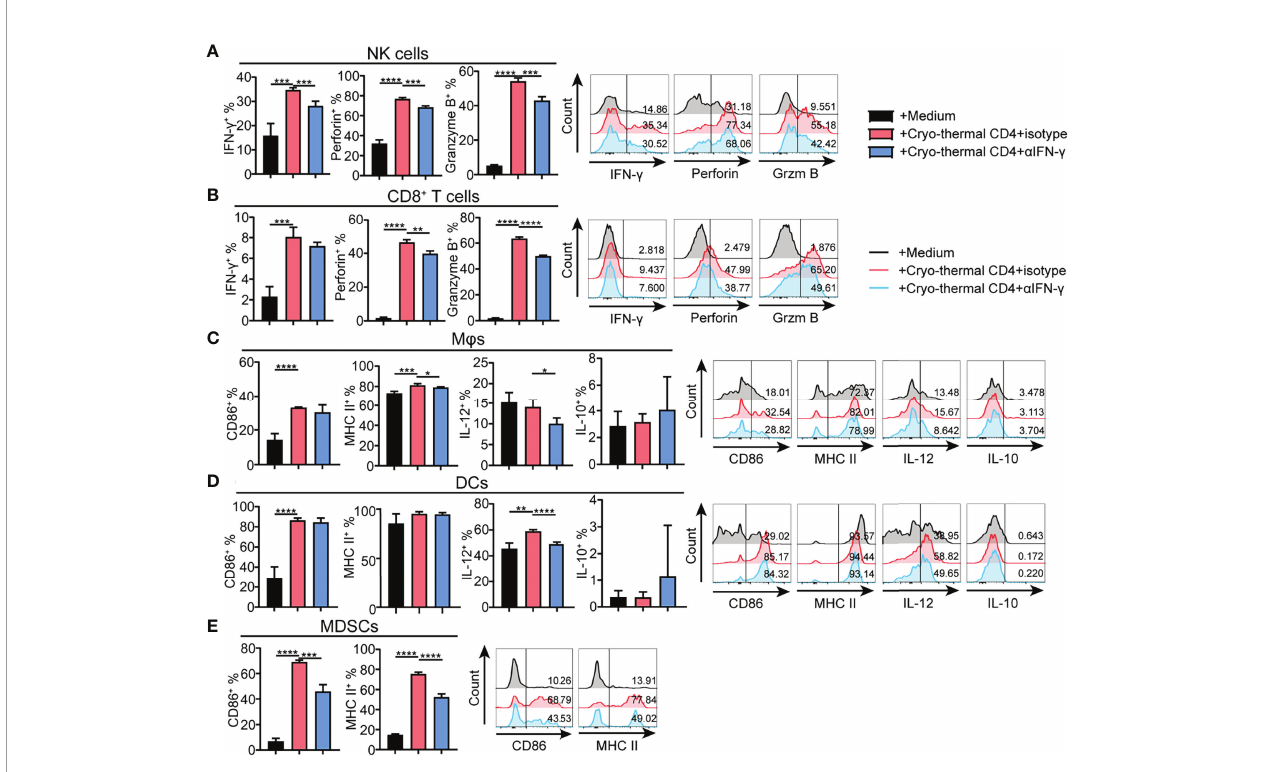
FIGURE 6 | Phenotype of immune cells regulated by cryo-thermal CD4 + T cells derived IFN- g in vitro . (A-E) MACS-isolated cryo-thermal CD4 + T cells were stimulated with anti-CD3 monoantibody, washed and then cocultured with cryo-thermal CD4 - splenocytes in the presence of 10 m g/mL isotype or anti-IFN- g antibody for 24 hours. As a control, CD4 - splenocytes were cultured with 5 ng/mL recombination IFN- g alone. The phenotype of (A) NK cells, (B) CD8 + T cells, (C) M j , (D) DCs and (E) MDSCs were analyzed by fl ow cytometry. All data were shown as mean±SD. n =4 for each group. *P < 0.05, **P < 0.01, ***P < 0.001, ****P < 0.0001. Data for graphs were calculated by using two-sided Student ’ s